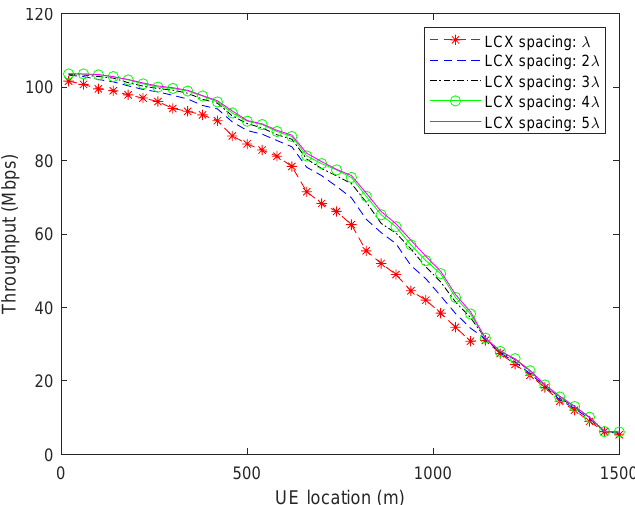
Figure 7. The effect of the LCX spacing interval on the throughput—2T2R (LCXs on the near